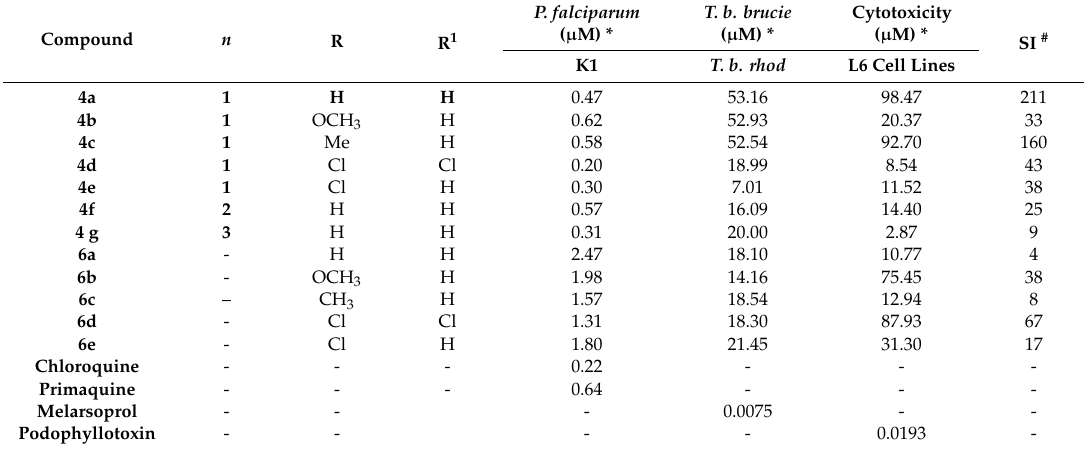
Table 1. In vitro antiplasmodium and antitrypanosomal activity, and cytotoxicity of the synthesized target